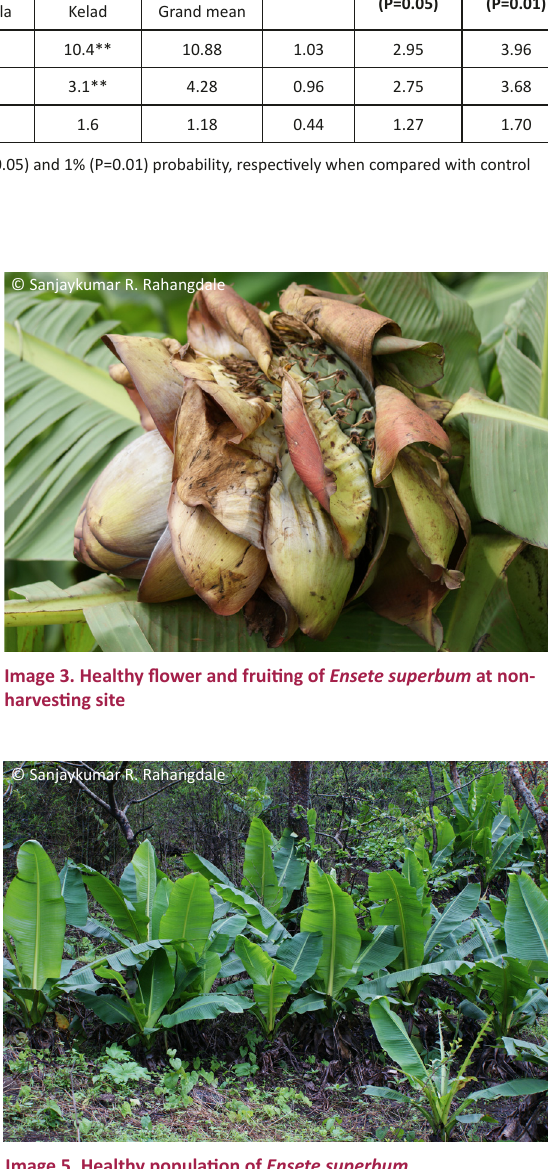
Image 5. Healthy population of Ensete superbum